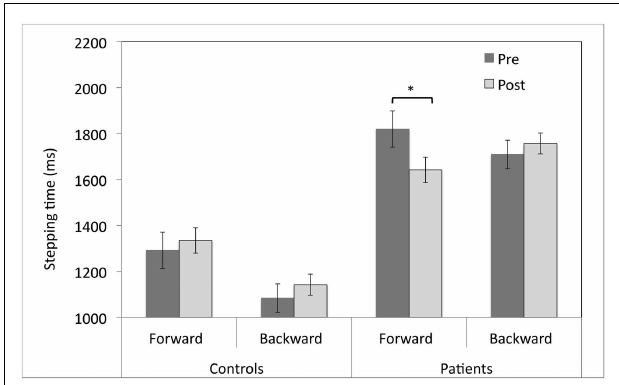
FIGURE 4 | Pre- and post-adaptation reaction times (ms) for forward and backward stepping for patients with Parkinson’s disease and control participants who adapted to upward-shifting prisms. * p < 0.05, error bars represent ± 1 SEM.